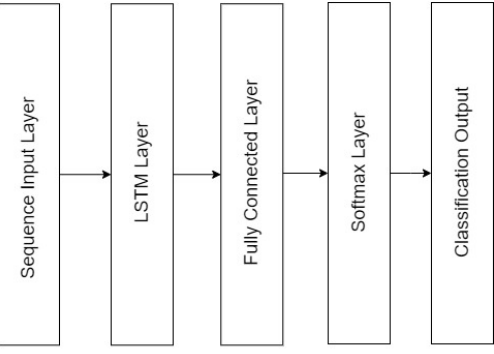
Figure 4. Neural network structure used for EEG-based